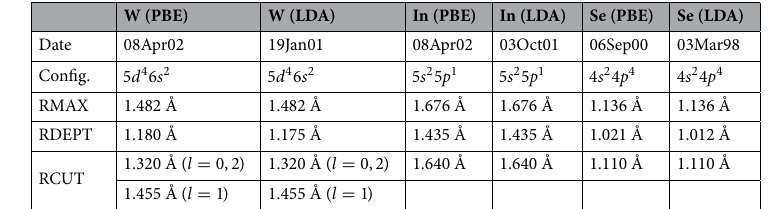
Table 2. Details of projector augmented wave (PAW) pseudopotentials used in VASP calculations of WSe 2 and InSe. The date identifies the generation of the specific pseudopotential. Config. gives the valence electron configuration of the calculation. RMAX is the core radius for the PAW projector operator, RDEPT is the core radius for the augmentation charge, and RCUT is the core cutoff radius.